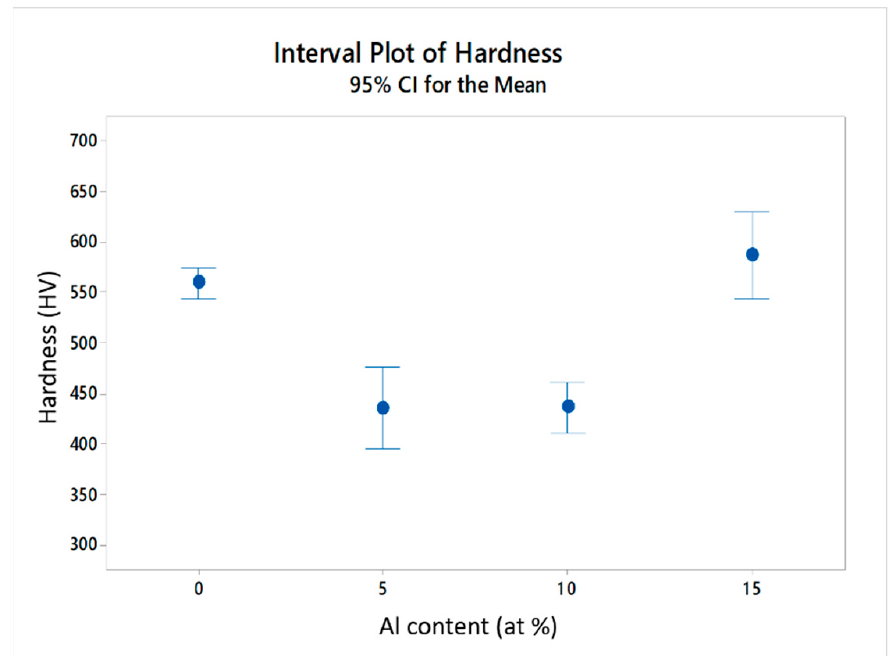
Figure 5. Microhardness as a function of the Al content. In details, the thermally stabilized binary CuZr alloy shows perfect linear behavior during the first cycle, while the second one exhibits a superelastic behavior with a more than intensive linear strain hardening effect, which is correlated with the high temperature phase (see DSC scan of Figure 3a). This response remains present up to the fifth cycle, during which the failure occurred before reaching the maximum stress during the